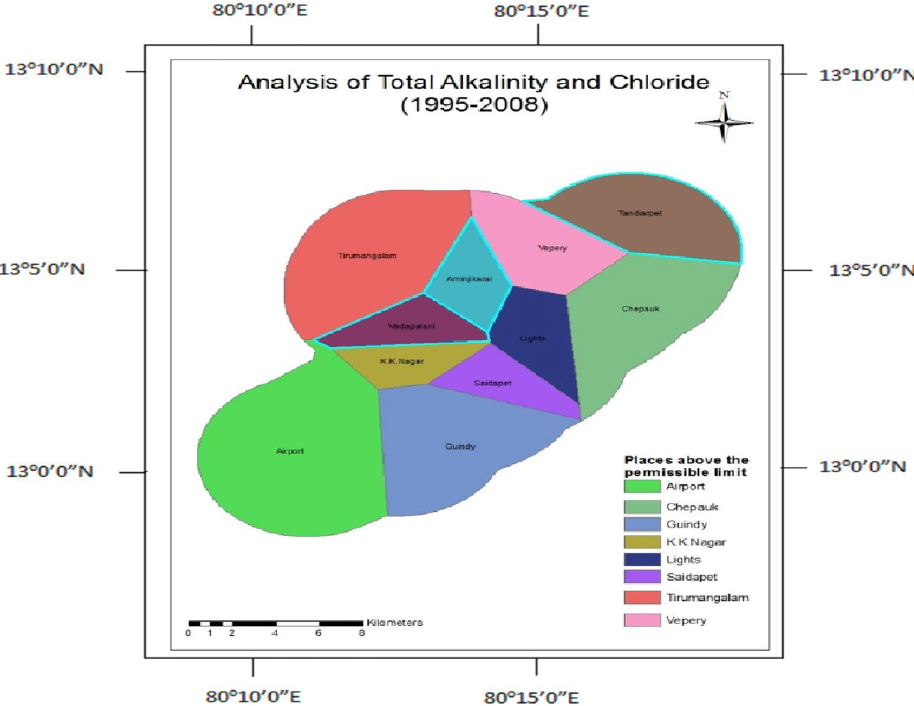
Figure 15. Analysis of total alkalinity and chloride for 1995–2008.